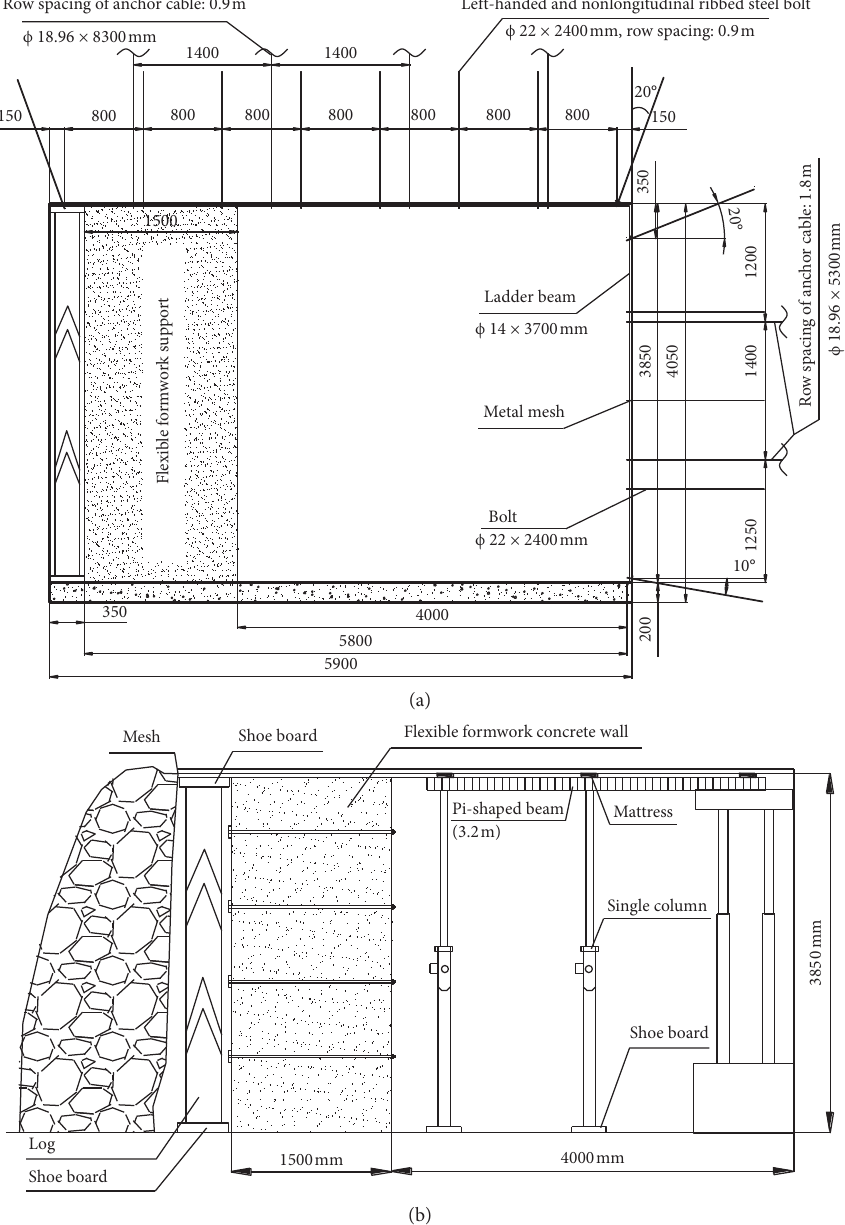
Figure 2: Roadway support form. (a) The supporting profile of the intake entry. (b) The shelf supporting profile of E1316 intake